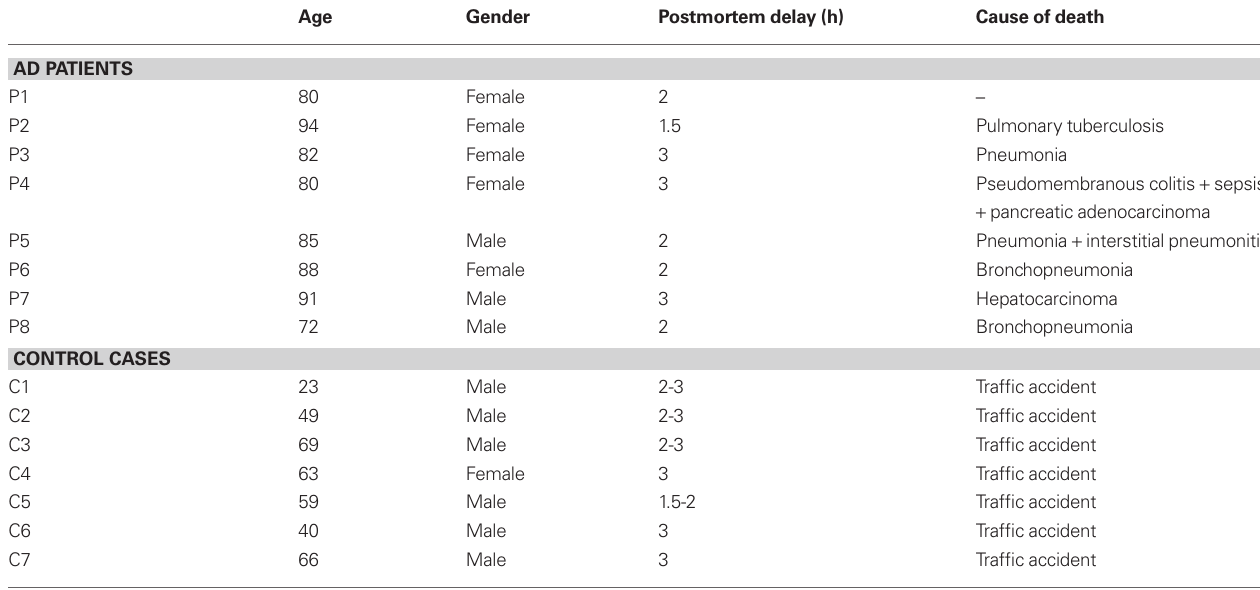
Table 1 | Summary of case data.